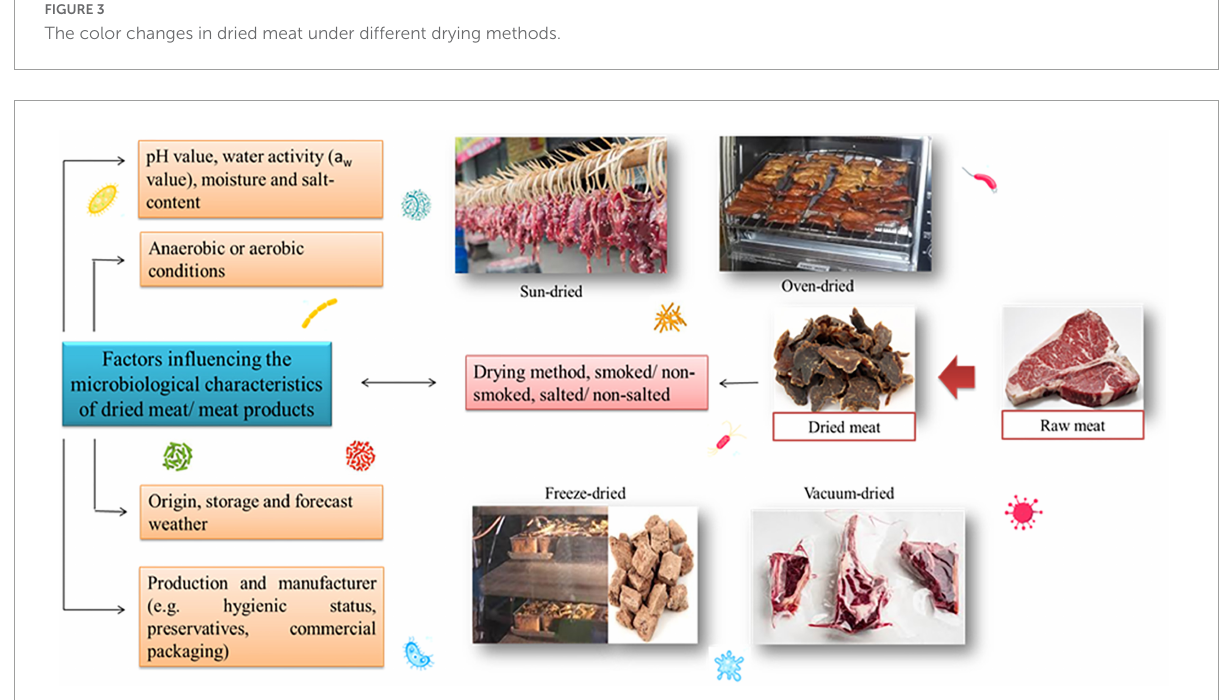
FIGURE4 The multifactorial influences on microbiological characteristics of dried meat and meat